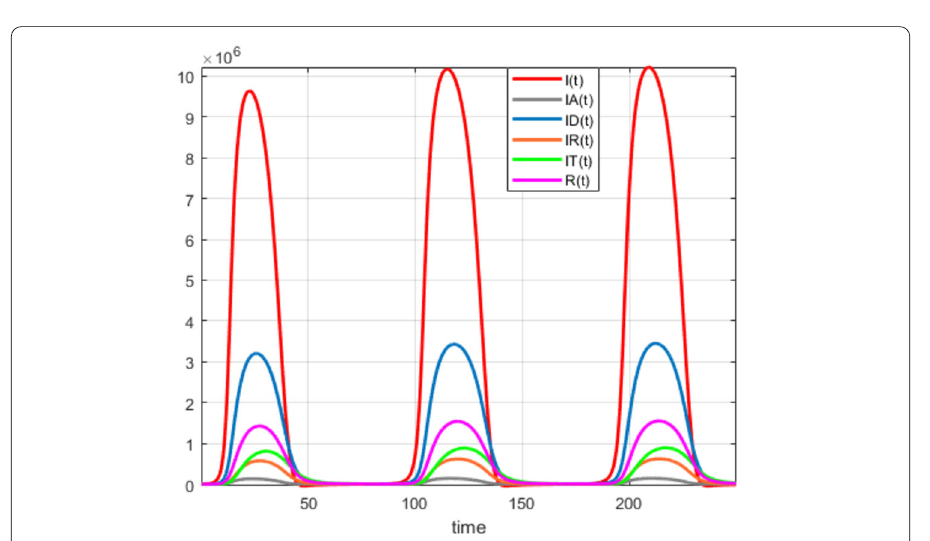
Figure 34 Numerical visualization of COVID-19 model for α =